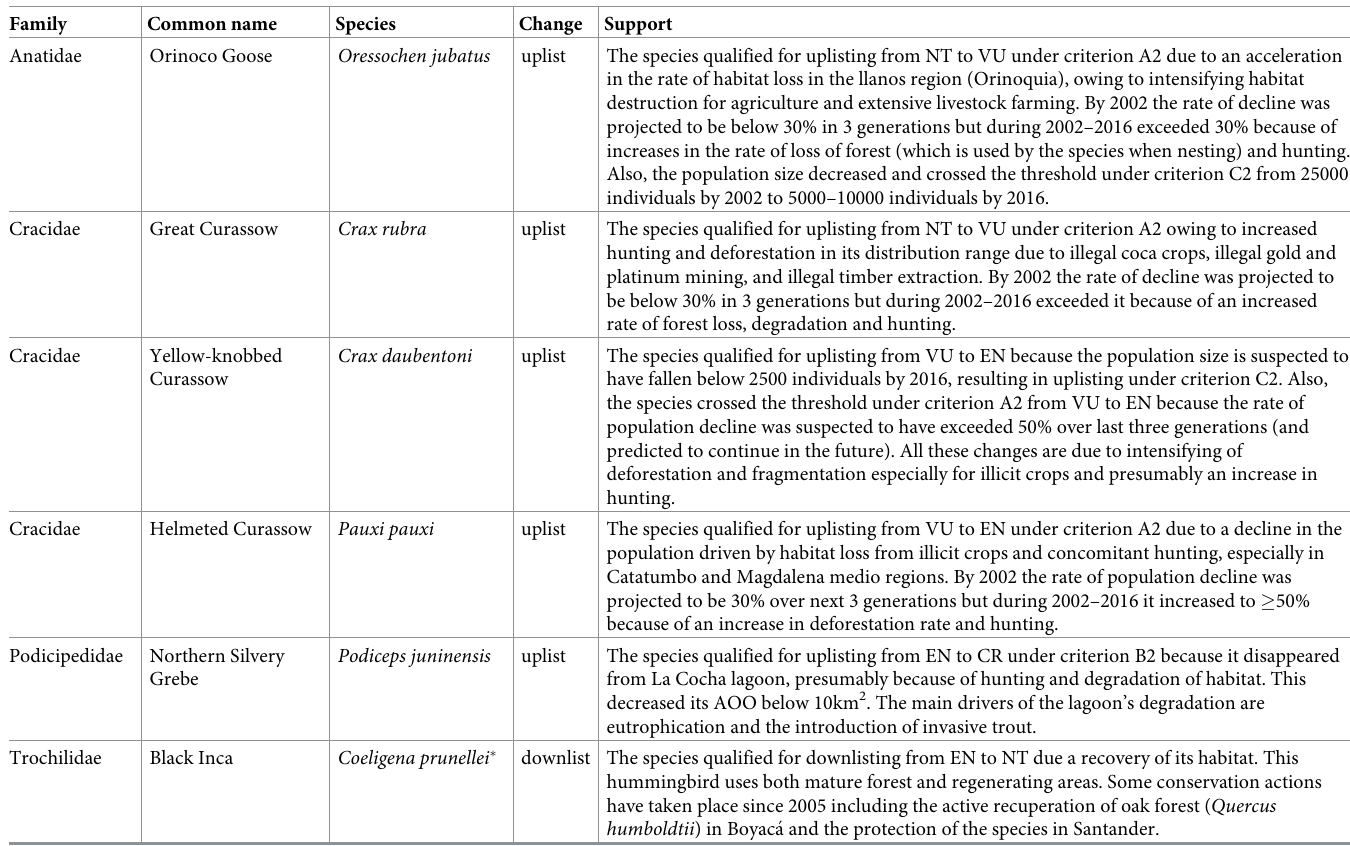
Table 2. Genuine changes suffered by species during 2002–2016 period. Endemic species are marked with asterisk �